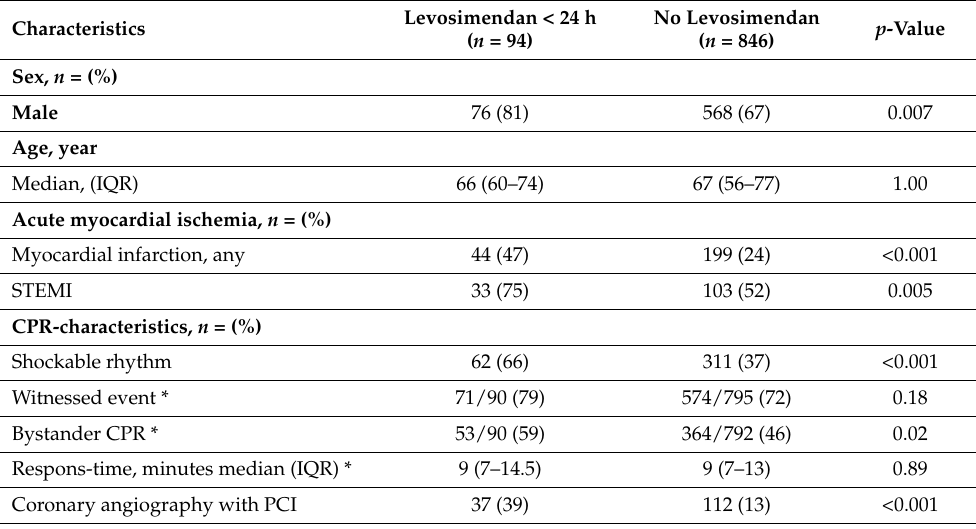
Table 1. Baseline characteristics in out-of-hospital-cardiac arrest patients admitted to the intensive care unit in Stockholm, Sweden, 2010–2016.